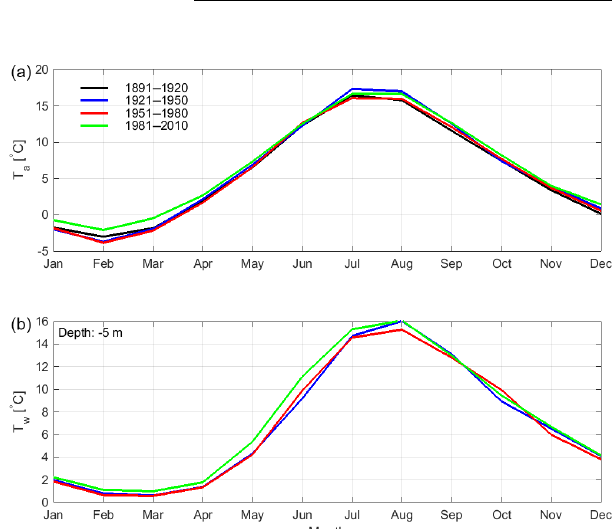
Figure 12. Monthly average air temperatures (a) and sea surface water temperatures (b) at Utö during the four 30-year reference pe-